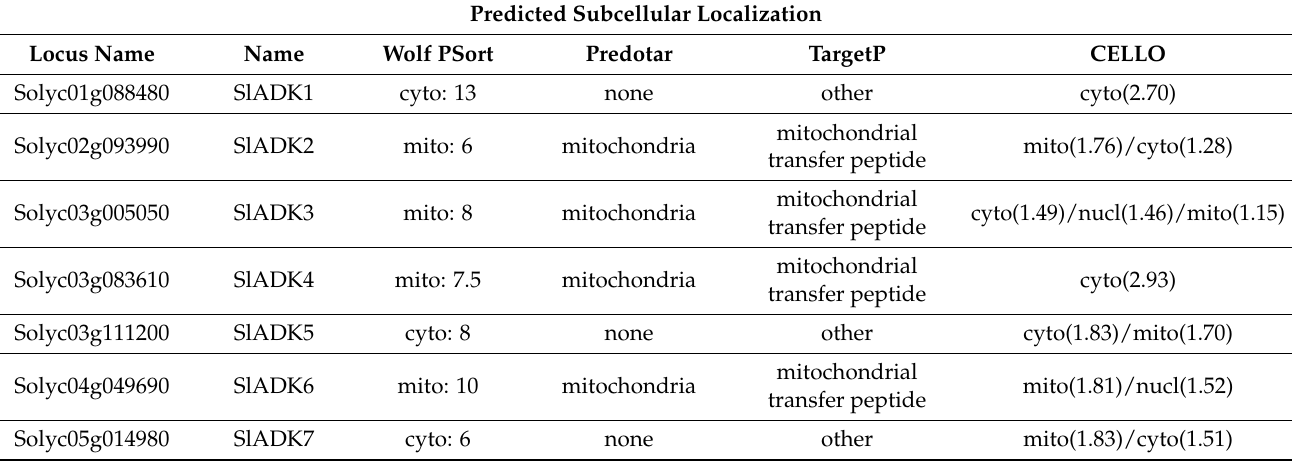
Table 2. Predicted subcellular location of SlADK family